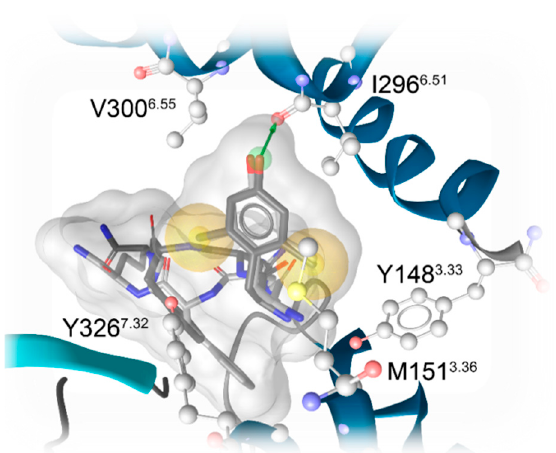
Figure 7. Ligand–MOR interaction pattern derived from molecular docking solutions of opioid peptides DAMGO, DALDA, [Dmt 1 ]DALDA, and KGOP01. Yellow fields indicate lipophilic contacts, red fields hydrogen bond acceptors, green fields hydrogen bond donors, and positively charged centers are shown as blue fields. White fields indicate the absence of an interaction with that residue. Residues which show the same type of interaction for all morphinan ligands are marked in bold.